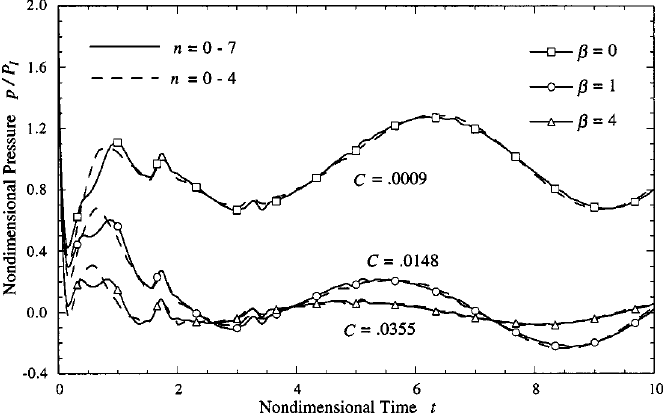
Fig. 3. External-surface pressure histories at (cid:18) = (cid:25) for an empty spherical shell excited by plane step-exponential waves.